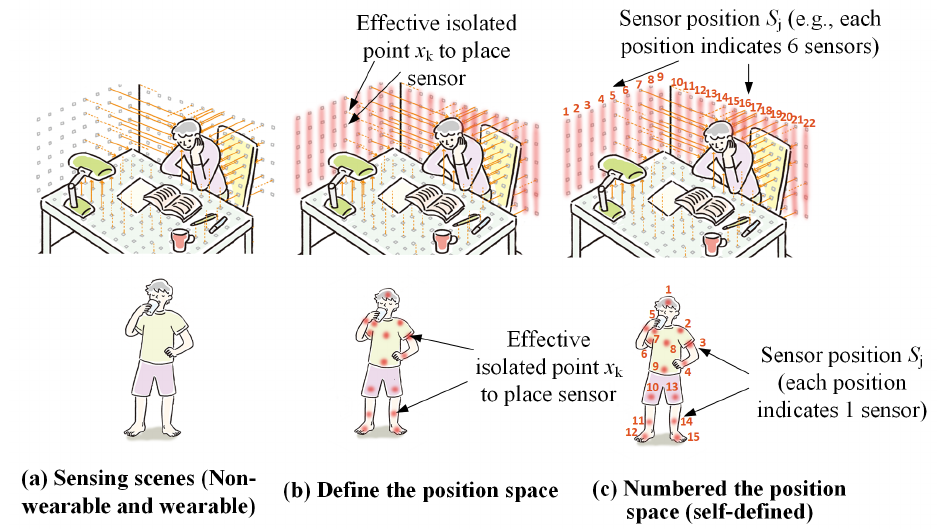
Figure 2. Sensor position illustration for different types of HAR system; ( a ) is the applied scene; ( b ) shows several effective isolated sensor points (such as the wall and significant joints of the body); and ( c ) is the predefined numbered position in the position space. For nonwearable types, one numbered sensor position can indicate several sensors (e.g., the figure shows six sensors at one position). For the wearable type, one sensor position indicates one